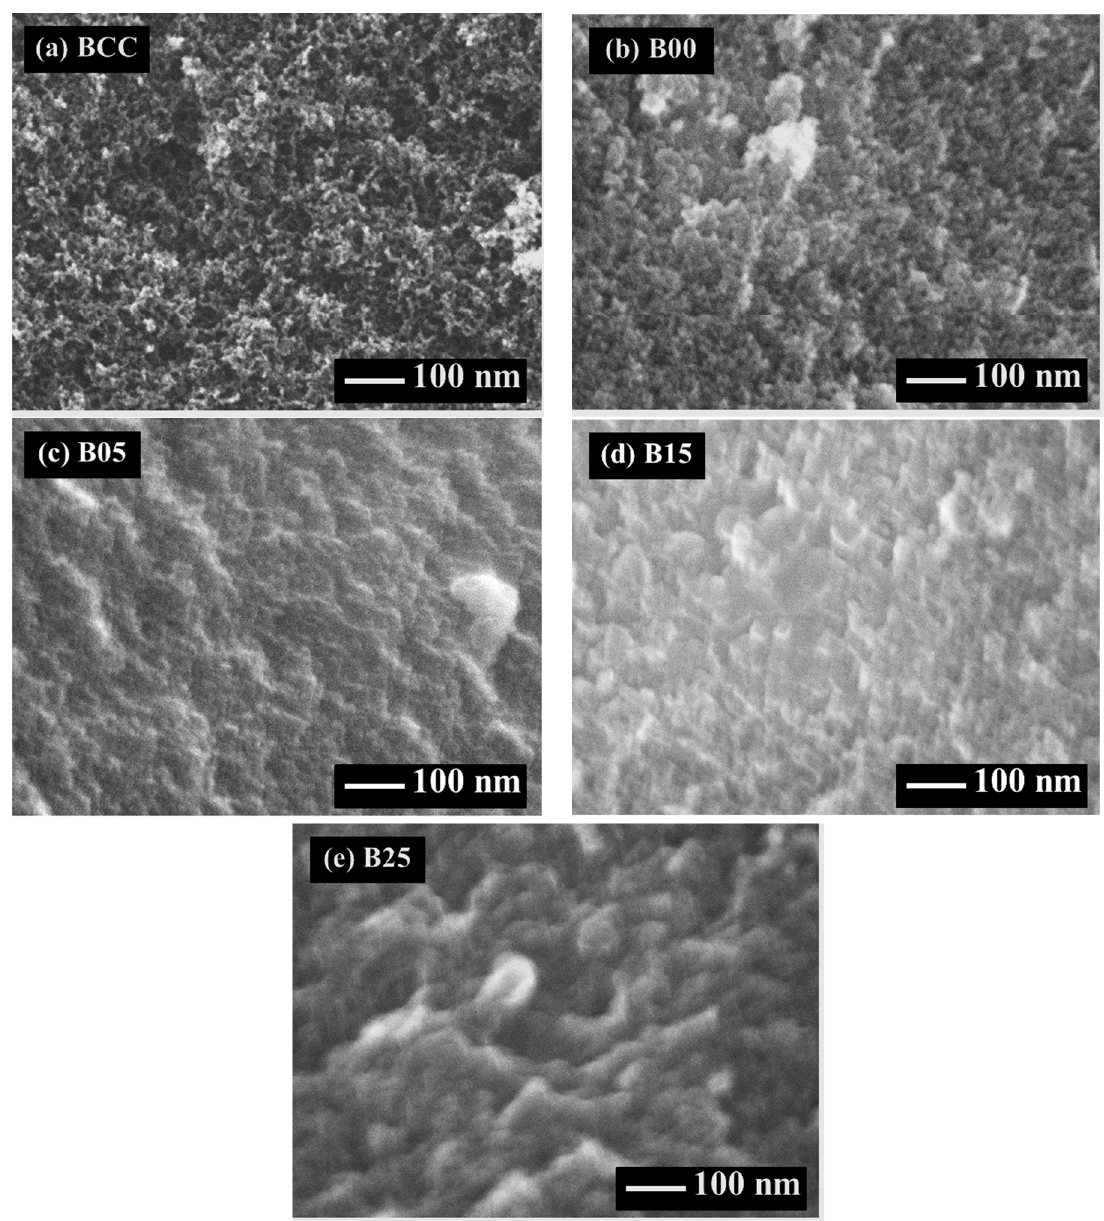
Figure 1. SEM images at 100,000 × magnification of mesoporous carbon prepared at R/C = 200 mol/mol and R/W = 0.25 g/cm 3 : ( a ) carbon cryogel, ( b ) carbon xerogel, ( c ) C/C composite xerogel at CF/RF = 0.05 g/g, ( d ) C/C composite xerogel at CF/RF = 0.15 g/g, and ( e ) C/C composite xerogel at CF/RF = 0.25 g/g.